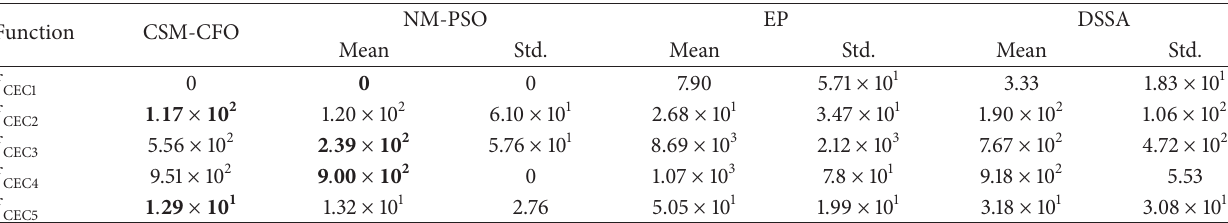
Table 7: Minimization result of CEC benchmark